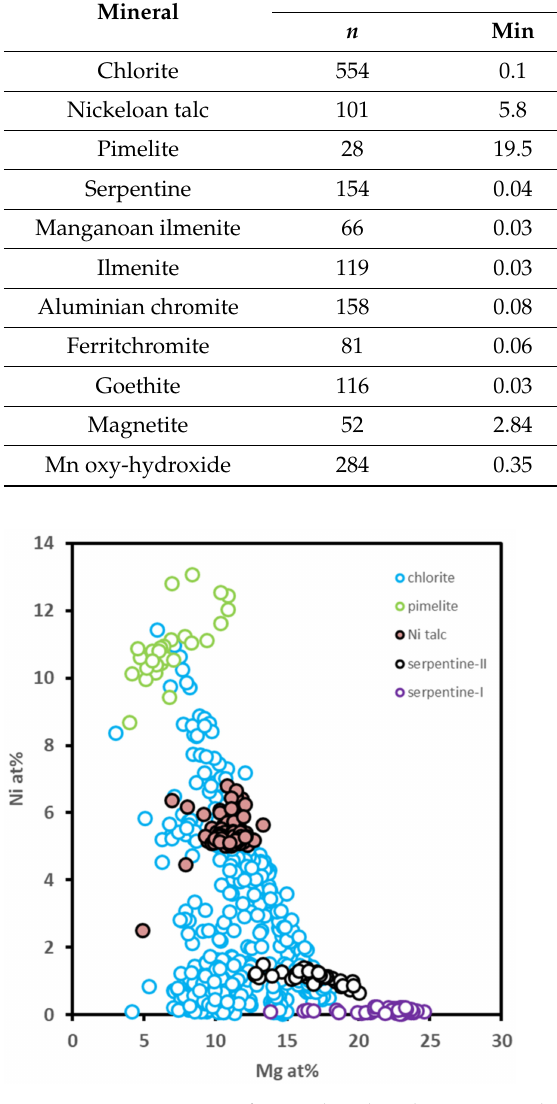
Figure 14. Partitioning of Ni within the silicate minerals across the Piau í laterite profile. The chlorite analyses all come from the SAPMG lithology. The Ni-rich serpentine analyses come from serpentinite- II, mostly in the SAPMG lithology and occasionally in the serpentinite. The low Ni analyses come from serpentine-I in the